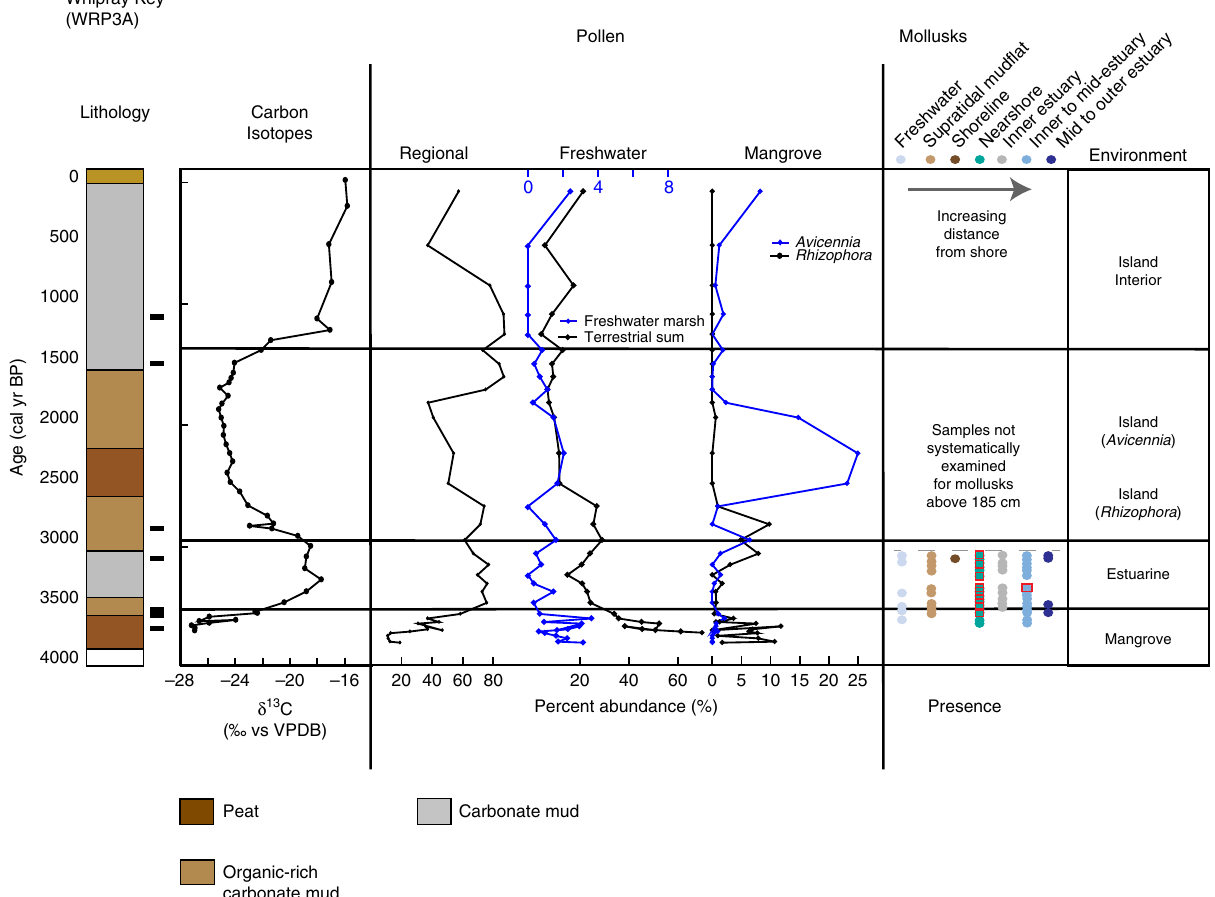
Fig. 5 Core summary diagram for Buttonwood #7 Key (WR). Carbon isotopes, selected pollen groups, and presence of mollusks. Regional pollen includes Pinus (pine) and Quercus (oak). Freshwater marsh sums include Poaceae, Cyperaceae, Nymphaea, Typha, Rhynchus, Cladium, Schoenoplectus, Sagittaria, Crinum , and Amaryllidaceae. Terrestrial sum includes all taxa, except the regional taxa and mangrove taxa, as well as Batis maritima and Amaranthaceae. Mollusk presence is shown in order of increasing salt-water/estuarine habitat and distance from shoreline from left to right. Red squares indicate abundance or dominance in a given sample. Radiocarbon age control shown by black rectangle next to the lithology